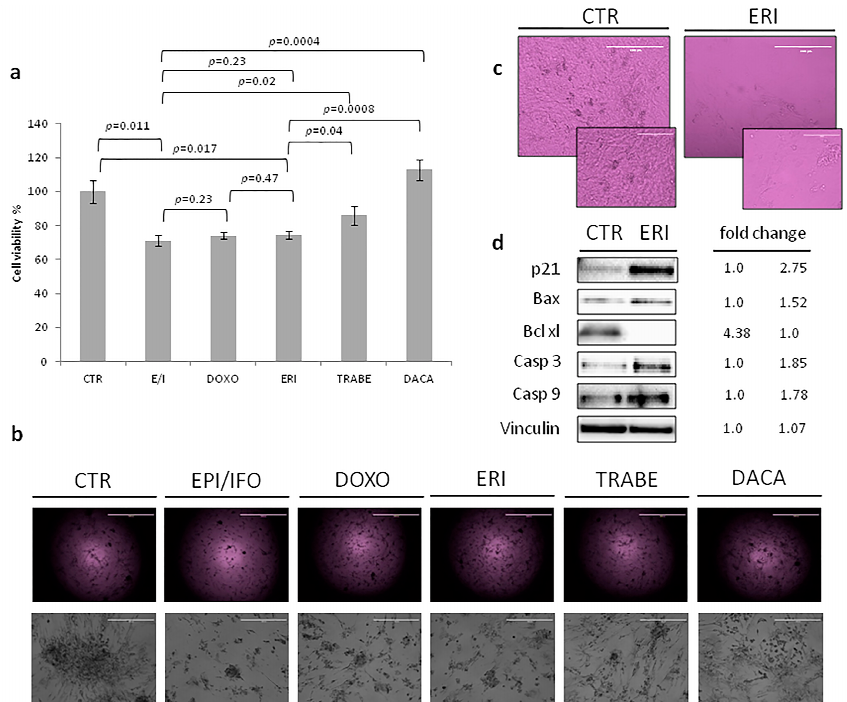
Figure 4. ( a ) Cytotoxicity assay in UPS primary culture exposed to the following drugs: epirubicin(EPI) plus ifosfamide (IFO), doxorubicin (DOXO), eribulin (ERI), trabectedin (TRABE), and dacarbazine (DACA). Differences between groups were assessed by a two-tailed Student’s t -test, and accepted as significant at p < 0.05; ( b ) Images of the primary culture after treatment (2 × and 10 × magnification, scale bar 2000 µ m and 400 µ m, respectively); ( c ) Morphological features observed in the primary culture after ERI treatment (20 × and 40 × magnification, scale bar 200 µ m and 100 µ m, respectively); ( d ) Western blot analysis of apoptosis-related proteins (p21, BAX, Bcl-xL; caspase-3 and caspase-9). Vinculin was used as loading control. Fold changes of band density were normalized to the band of the CTR group.